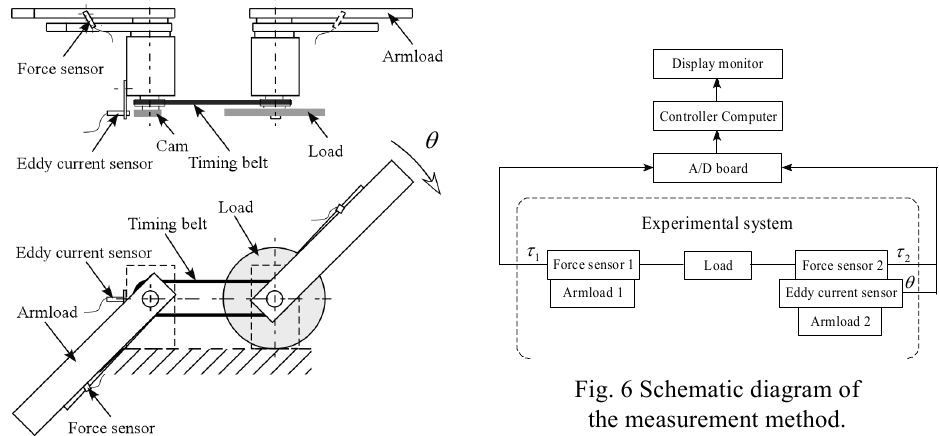
Fig. 6 Schematic diagram of the measurement